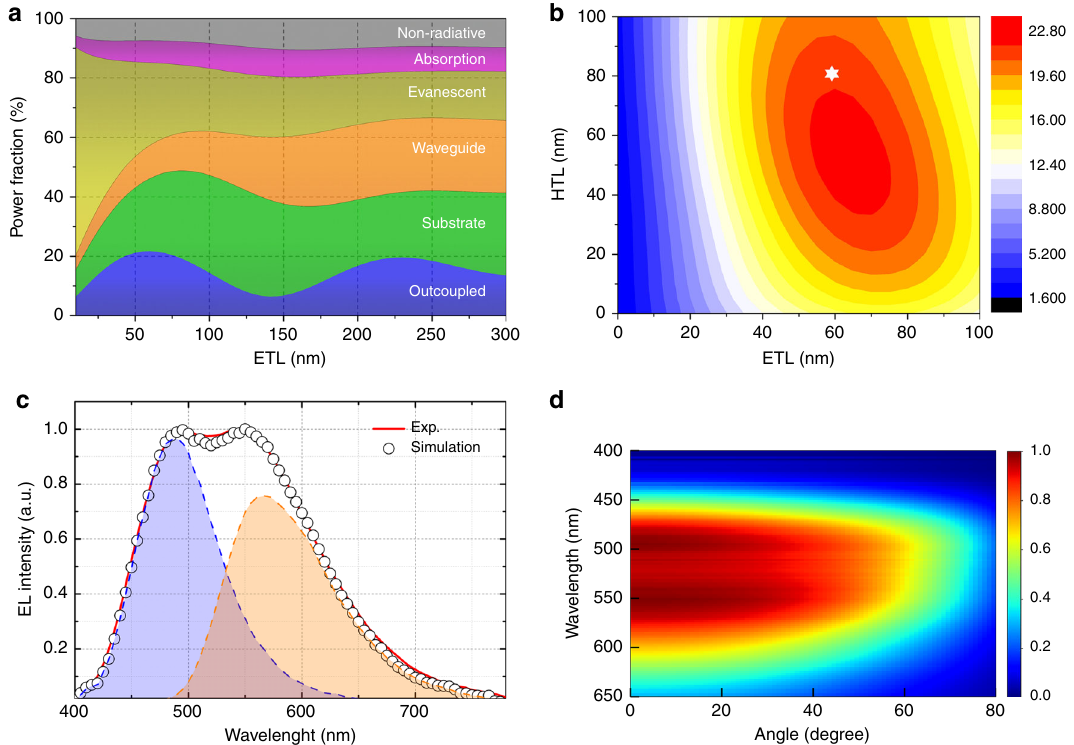
Fig. 5 Optical simulation. a Simulated photon distribution of all loss channels in dependence of the electron-transporting layer (ETL) thickness in the present white organic light-emitting diodes (WOLEDs). Most generated photons remain in waveguided and evanescent modes. b Calculated extraction ef fi ciency from the simulated photon distribution of the present WOLEDs, HTL denotes the hole-transporting layer. The pentagram symbol represents the theoretical maximum external quantum ef fi ciency (21.7%) in our proposed structure. c The experimental and theoretical spectra of the WOLEDs according to the monochrome blue and orange spectra. d Angular resolved spectral radiant intensity (SRI) of the present WOLED with the electron-transporting layer thickness of 60 nm at the brightness of 1000 cd m − 2 . The displayed is the SRI in dependence of the wavelength λ and polar angle